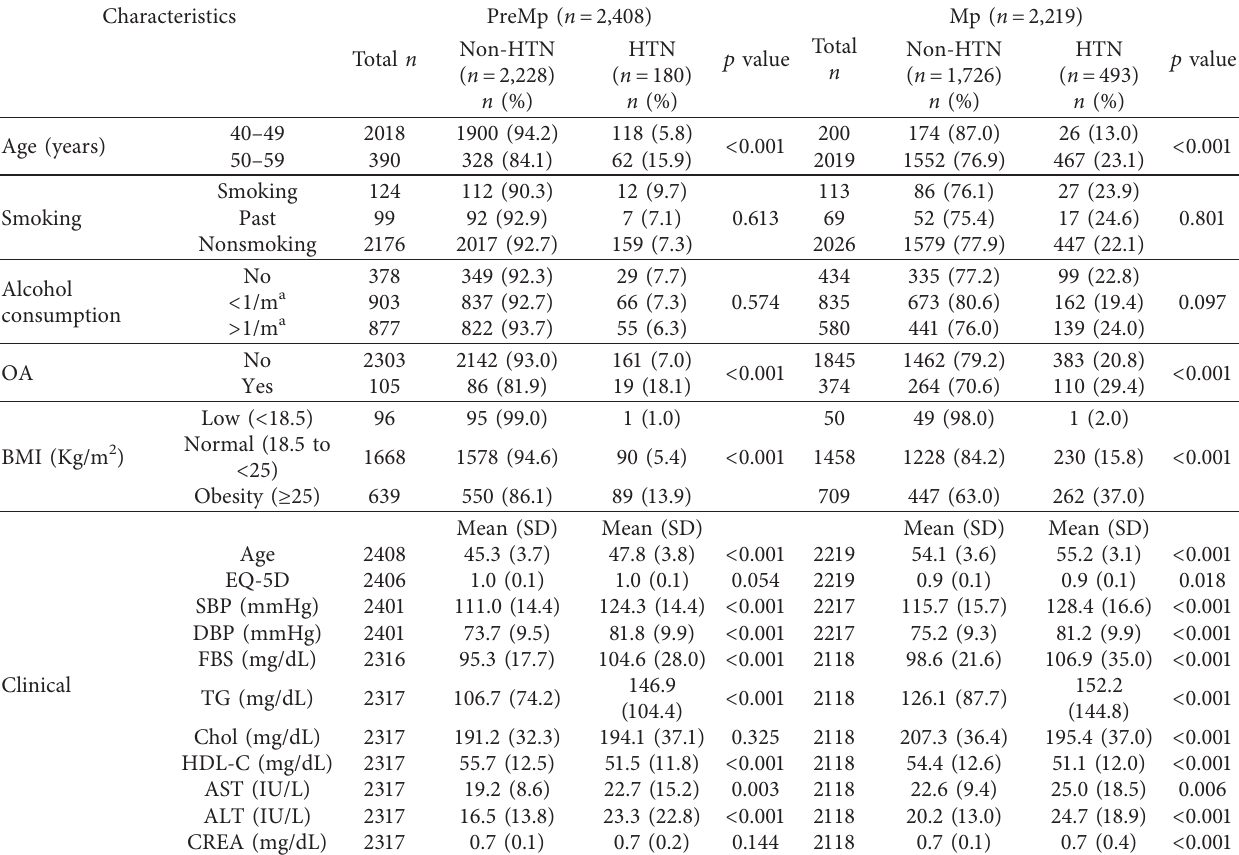
Table 3: Characteristics of the groups with and without hypertension according to the menopause status. Characteristics